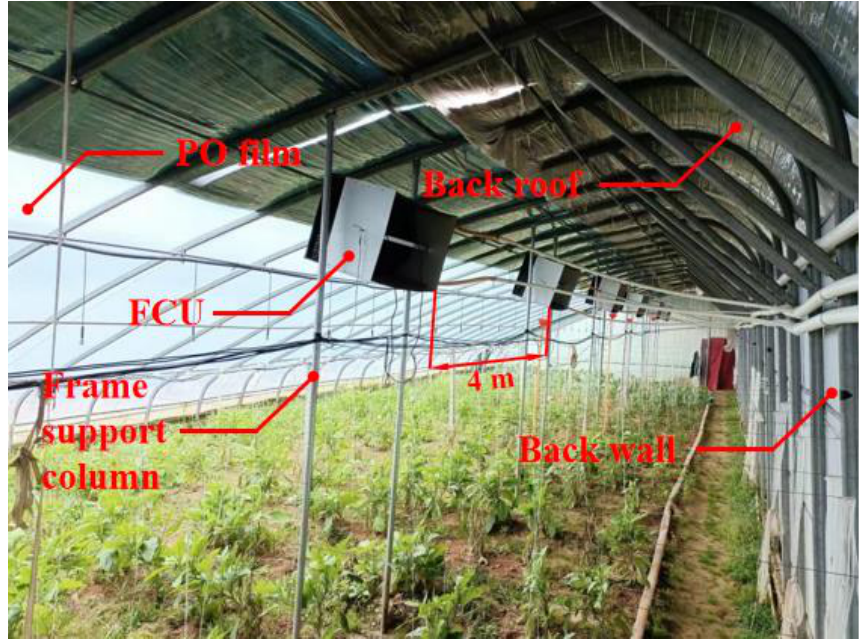
Figure 1. Layout diagram of FUC systems in experimental solar greenhouse.